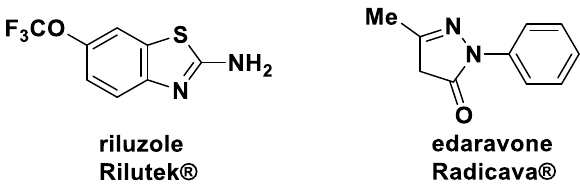
® ) and edaravone (Radicava ®